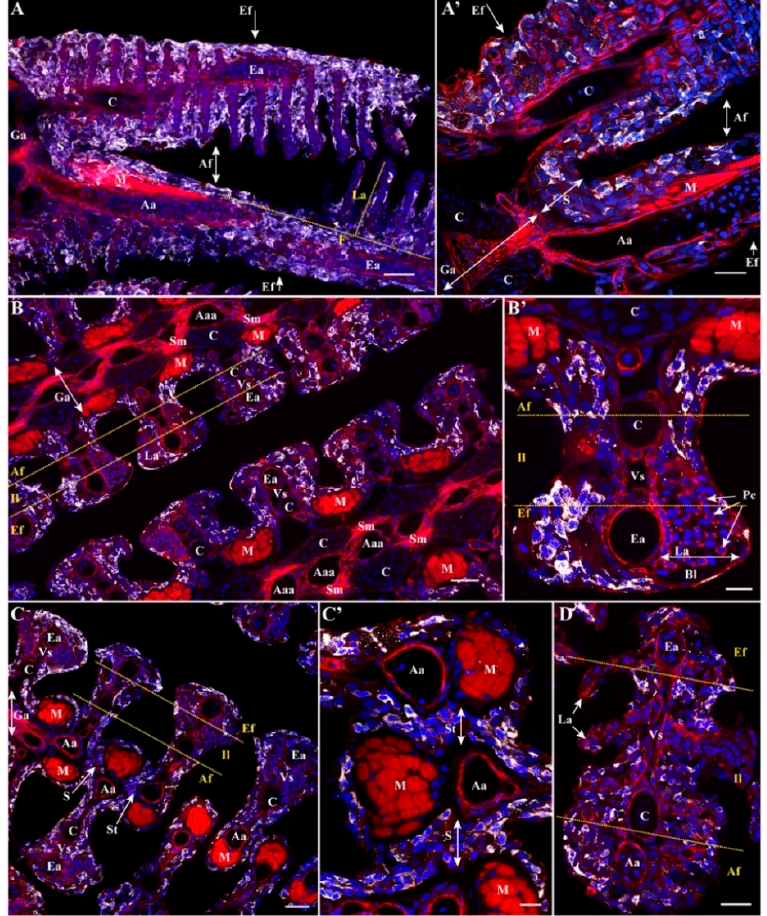
Figure 7. Gill-associated lymphoid tissues (GIALT) of medaka ( O. latipes ). Spinning disk confocal deconvolved images of adult medaka gills paratransversally sectioned ( A , A’ ), coronally sectioned beneath the septum ( B , B’ ), coronally sectioned across the septum ( C , C’ ) and coronally